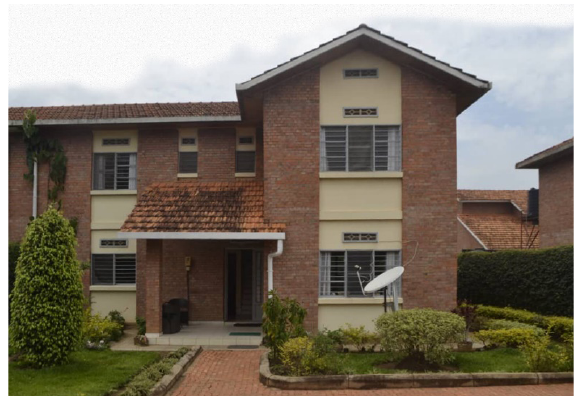
Figure 34. Twin House Type 4: Living room. Photograph by Manlio Michieletto.